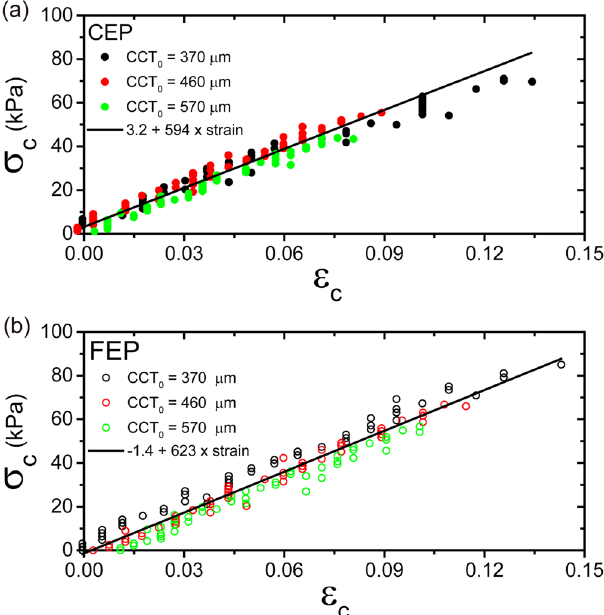
Figure 3. Circumferential stress (σ c )–circumferential strain (ε c ) curves for the cornea eyeball phantom ( a ) and the full eyeball phantom ( b ) derived from the data shown in Fig. 1( c – f ). The solid black lines are the results of the linear regression conducted on all of the